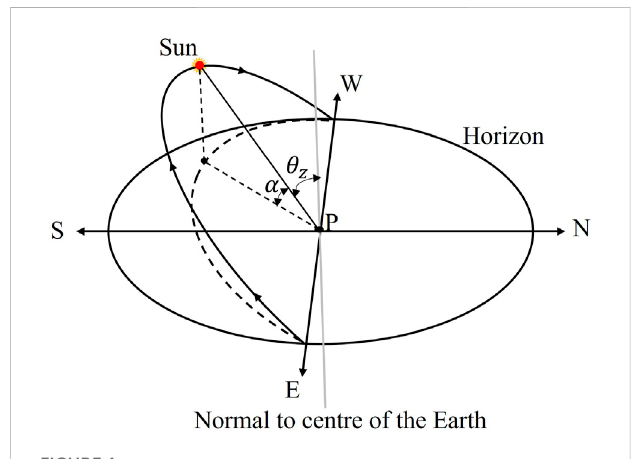
FIGURE 1 The altitude angle ( α ) and the zenith angle ( θ Z ) of the sun when viewed from point P, and α + θ Z = 90 °